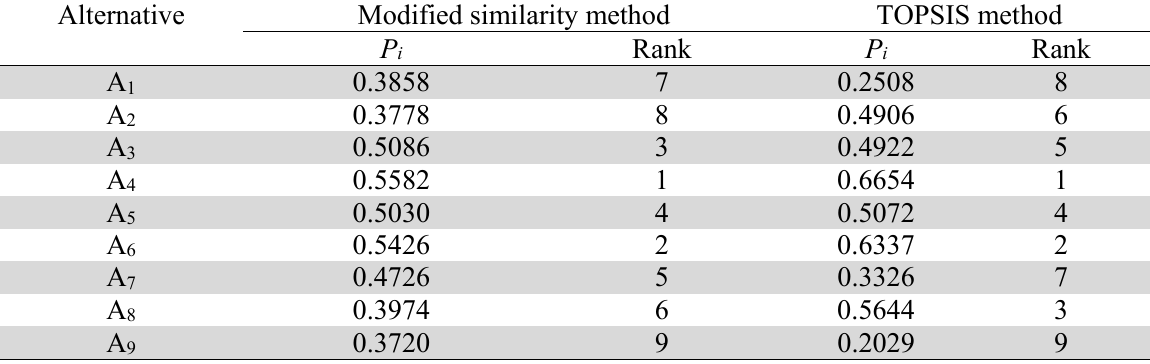
Comparison between modified similarity and TOPSIS methods for soluble oil selection problem